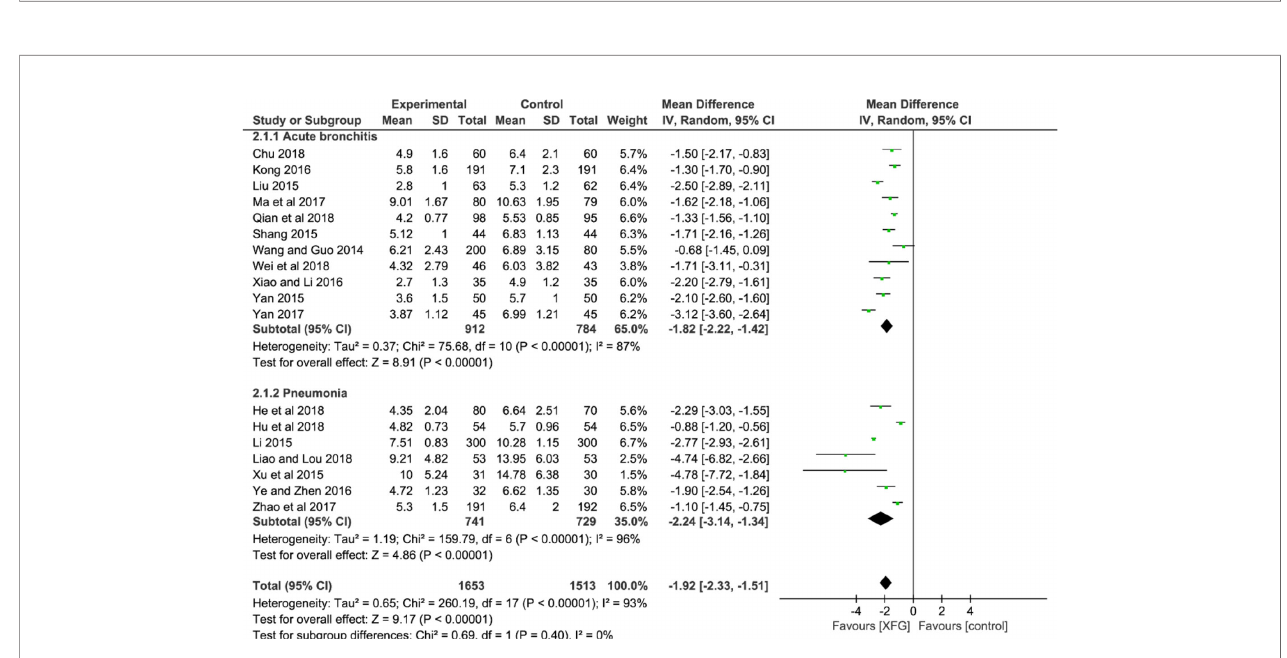
FIGURE 4 | Forest plot and subgroup analysis of the